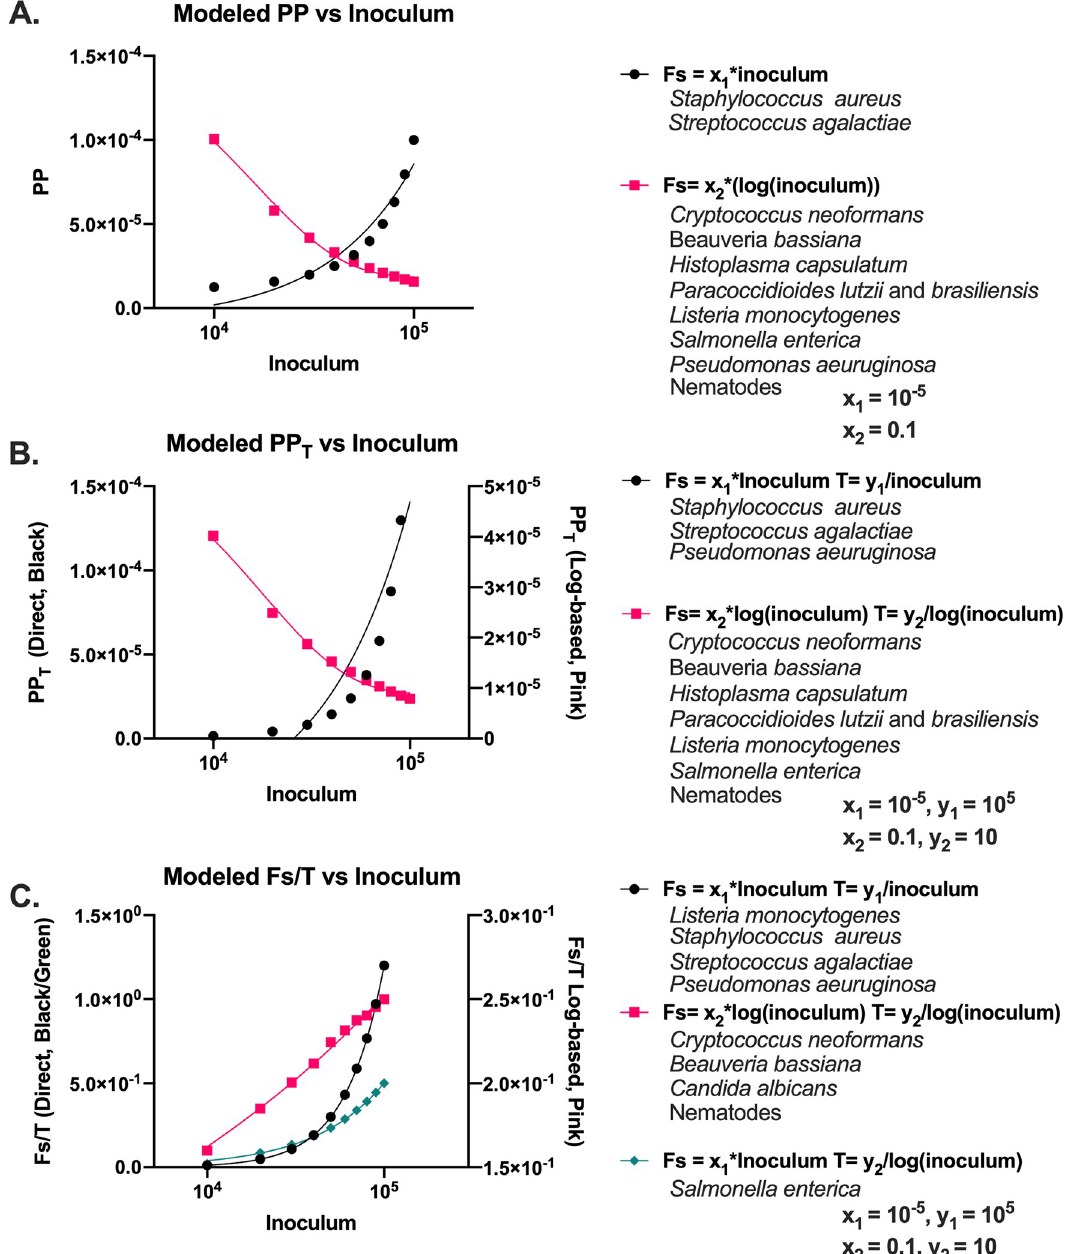
Fig 9. Modeled PP, PPT, and Fs/T values. Modeled PP (A), PP T (B), and Fs/T (C) values using linear-based methods of calculating Fs and T (black data points) or log-based methods of calculating Fs and T (pink data points), or a mix of both (green data points), as described by the formulas in the graph key. Example organisms that fall under each category are listed below their respective group. PP and PP T values are fitted with a one phase exponential decay function. The linear based Fs/T values (black and green points) are fitted using a simple linear regression, whereas the log-based values (pink points) are fitted using a semi-log line.